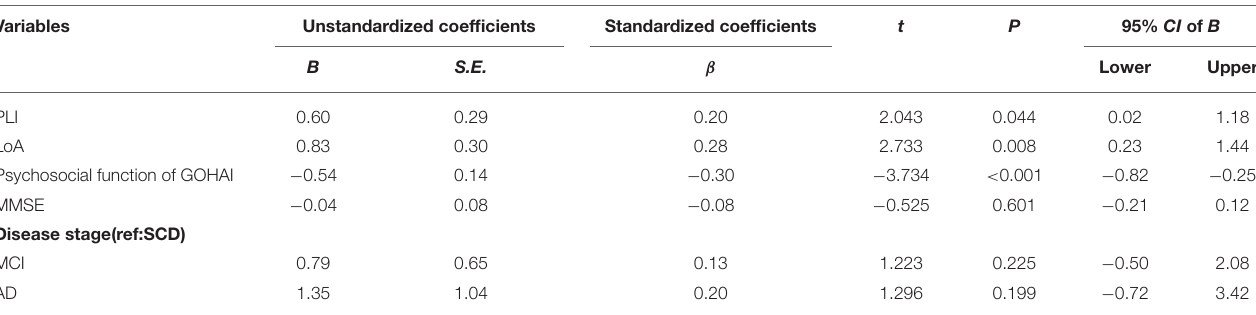
TABLE 4 | Analysis of the influencing factors of PS among participants.